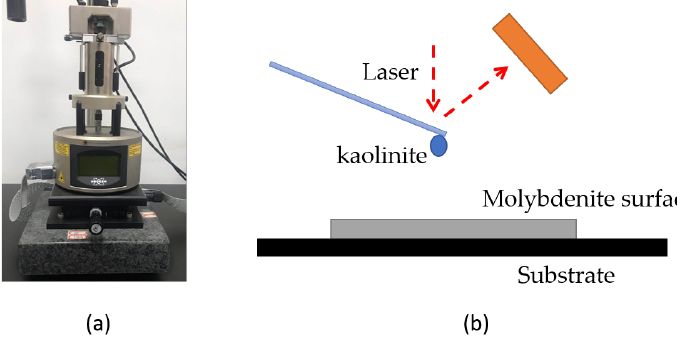
Figure 4. ( a ) Nanoscope Multimode 8 AFM; ( b ) Schematic of force measurements between molybdenite surface and kaolinite particle.